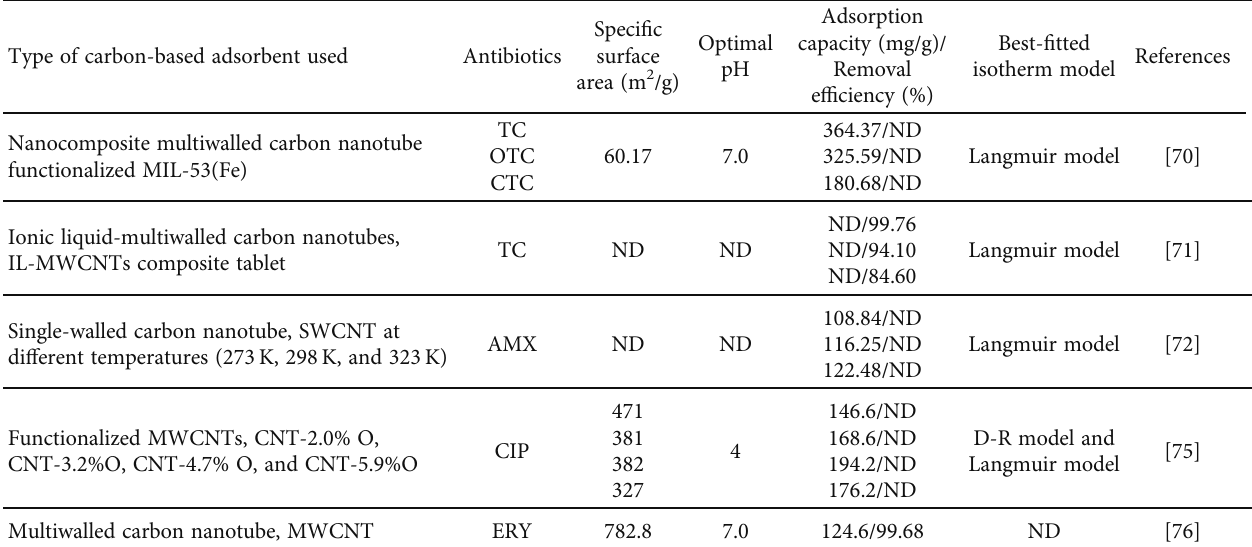
Table 3: Antibiotics adsorption by carbon nanotubes. The adsorptive characteristics of the adsorbents are summarised. ND: not